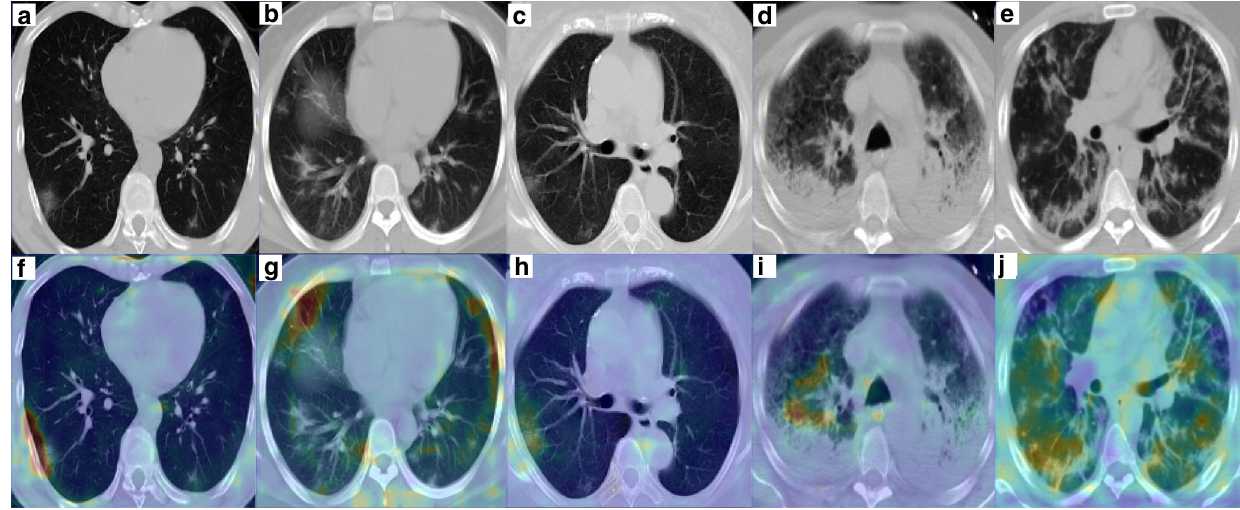
Fig. 3 Grad-CAM* resultant saliency maps for fi ve representative COVID-19 patients from testing set. All images are of correctly predicted positive by 3D model. Within the heatmap, areas of red indicate activation of the algorithm related with COVID-19 prediction. a , b Images and ( f , g ) associated maps from Hubei, China cohort. c Image and ( h ) associated map from Tokyo, Japan cohort. d Image and ( i ) associated map from an advanced case in Milan, Italy Center #1. Note activation in non-consolidating areas for prediction of COVID-19, indicating speci fi c features independent of pneumonia-related consolidation are learned. e Image and ( j ) associated map of an advanced case in Milan, Italy Center #2. Note: case ( e ) represents an unseen testing center from training/validation centers. *footnote: Grad-CAM images are produced from preprocessed input data, including cropping to lung region and resizing to fi xed dimension, which may result in visible changes to anatomic aspect Algorithm performance in unseen population domain conditions .